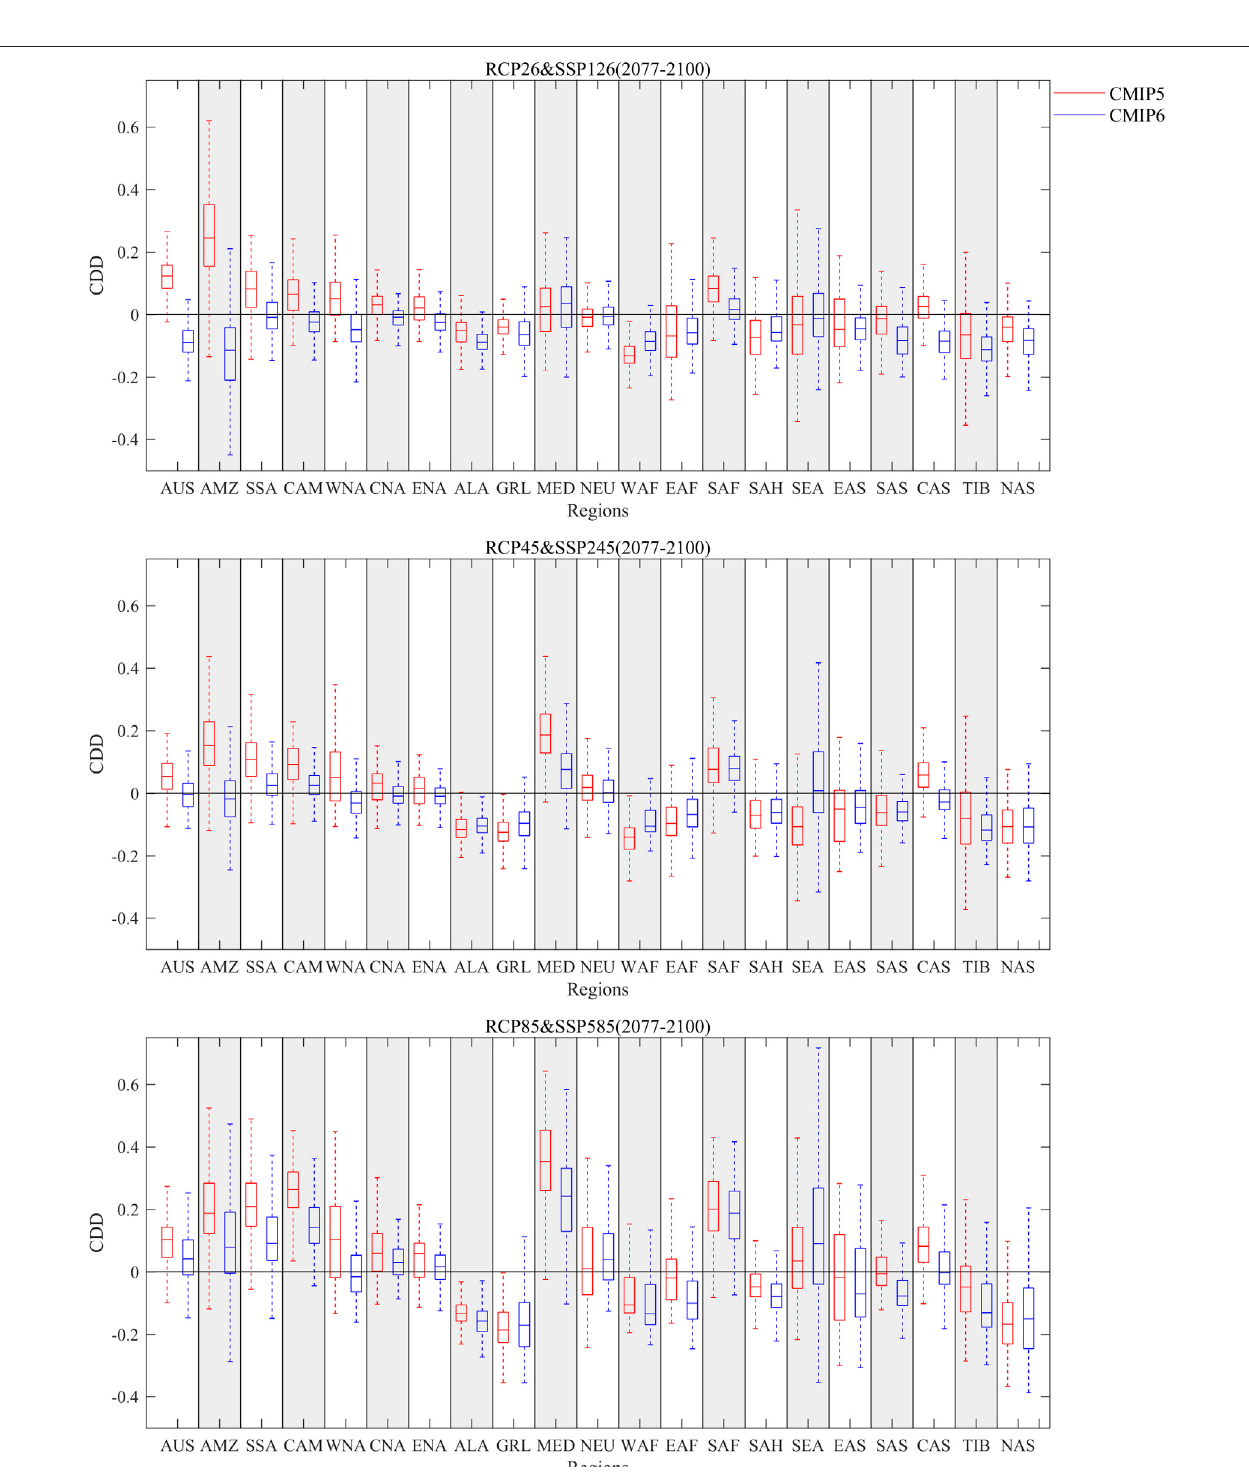
FIGURE 12 | Box plots for CDD multi-model mean changing rates in 21 regions in far-future period (2068 – 2100) over the historical period (1982 – 2005) in CMIP5 and CMIP6. CMIP5 is presented in red and CMIP6 is presented in blue.